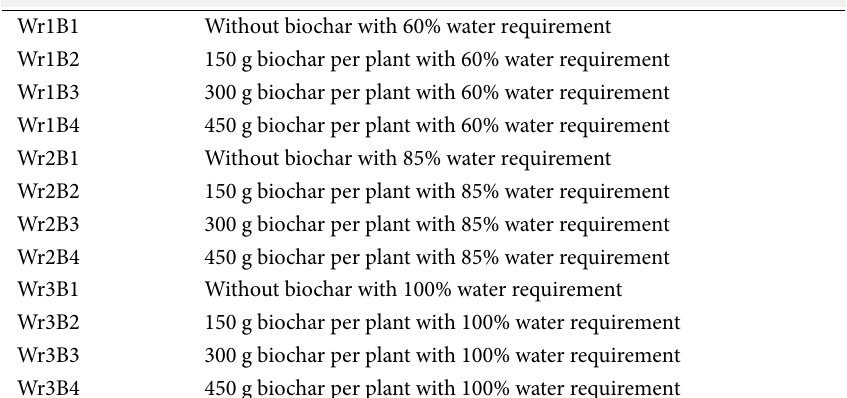
Table 3 Treatments of the